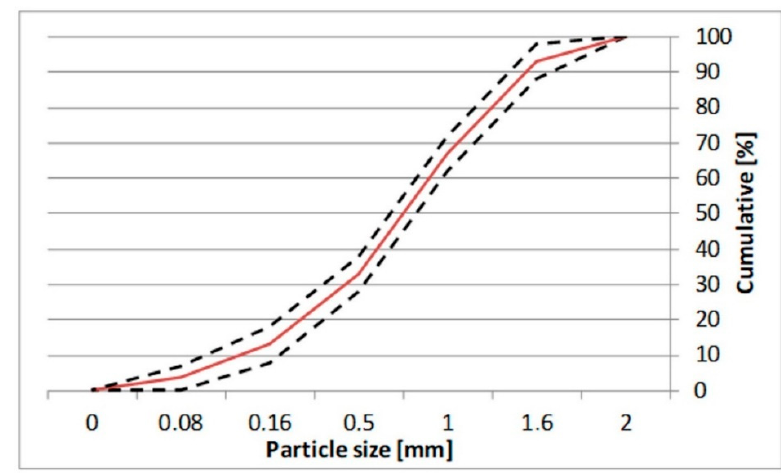
Figure 9. The grading curve of normal sand [34].